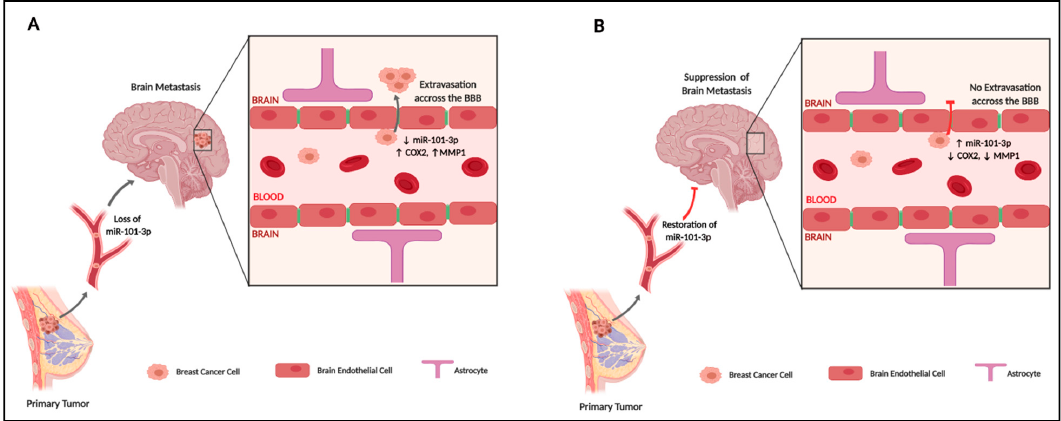
Figure 8. A proposed model for the pathological role of miR-101-3p in transmigration of metastatic breast cancer cells through the brain endothelium (created with BioRender).